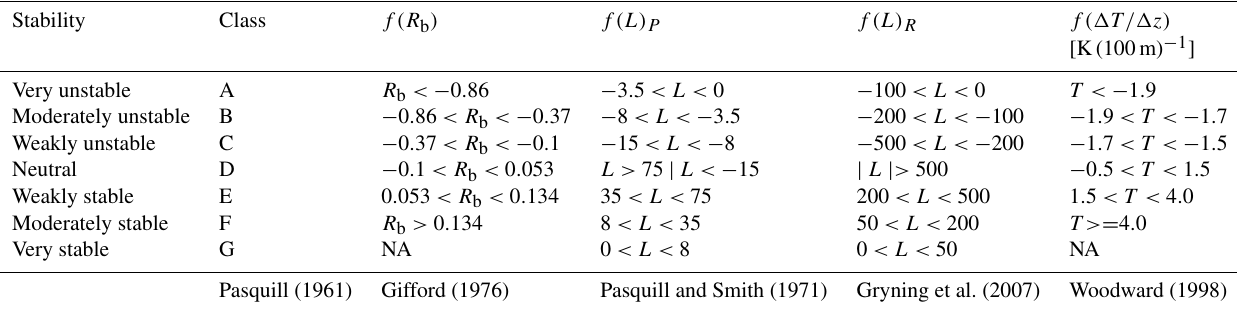
Table B1. Stability categories and Pasquill–Gifford classes based on literature, as a function of bulk Richardson number ( R b ), Obukhov length ( L ) and the temperature gradient with height. “NA” means “not